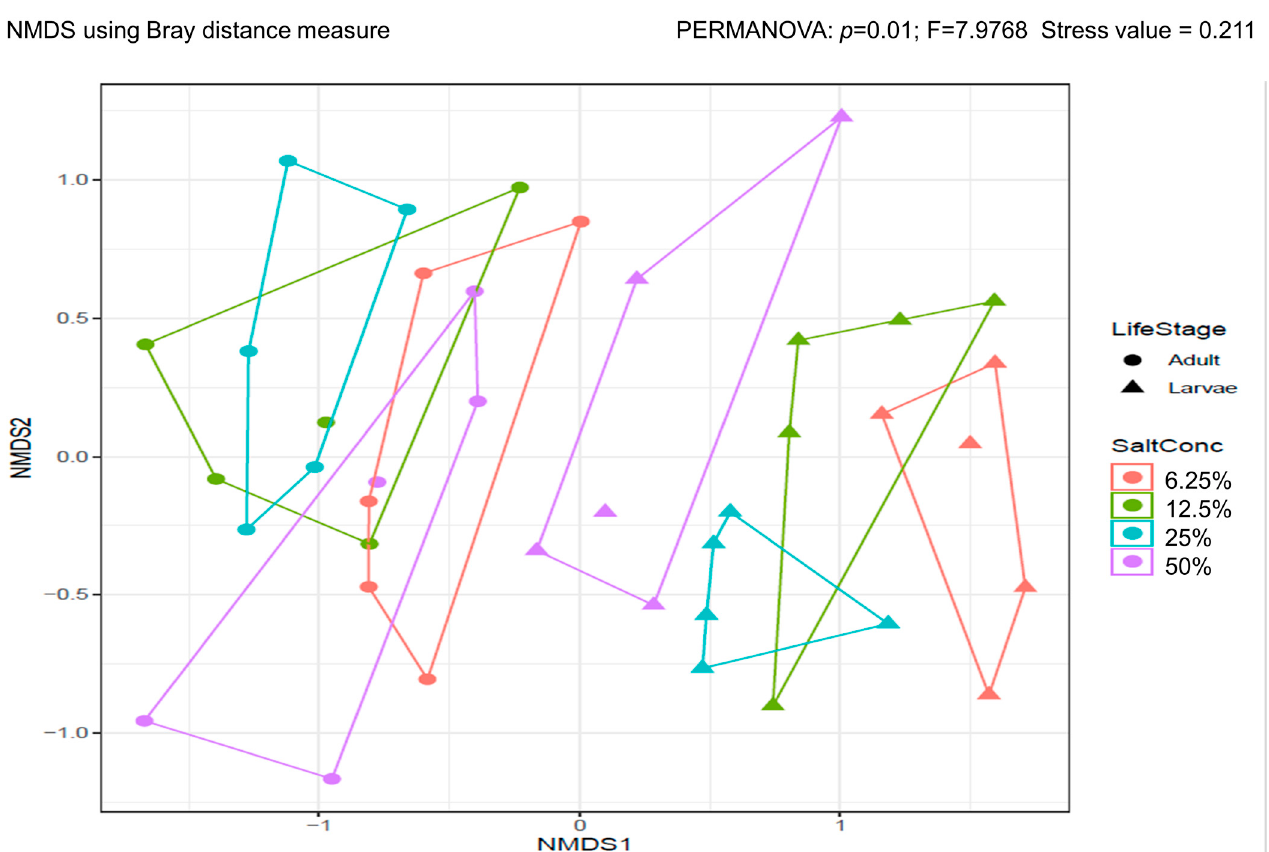
Figure 4. Beta diversity of 4th instar larvae and adult An. merus reared in differing larval salt concentration. Non-Metric Multidimensional Scaling plot of β -diversity. Larvae (triangles) from different salt concentrations cluster separately from the adults (circles) and are diverse from each other. Adults are also less diverse and their diversities overlap.